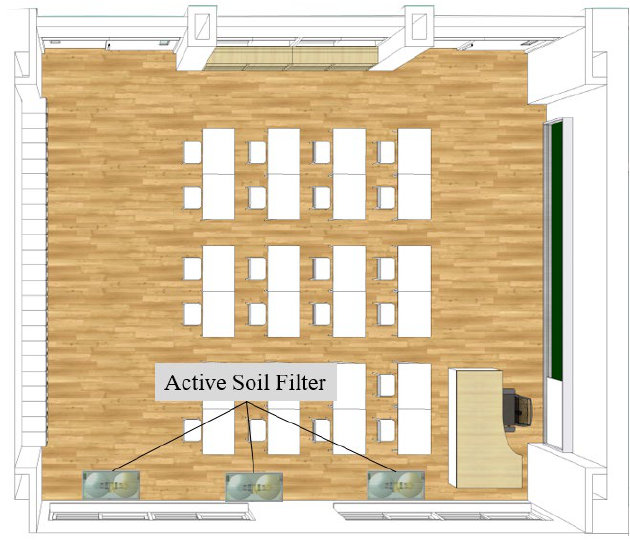
Figure 14. Installation positions of the active soil filter in a classroom. Table 5. Ventilation volume according to the inflow air velocities for three active soil filters in class- room.